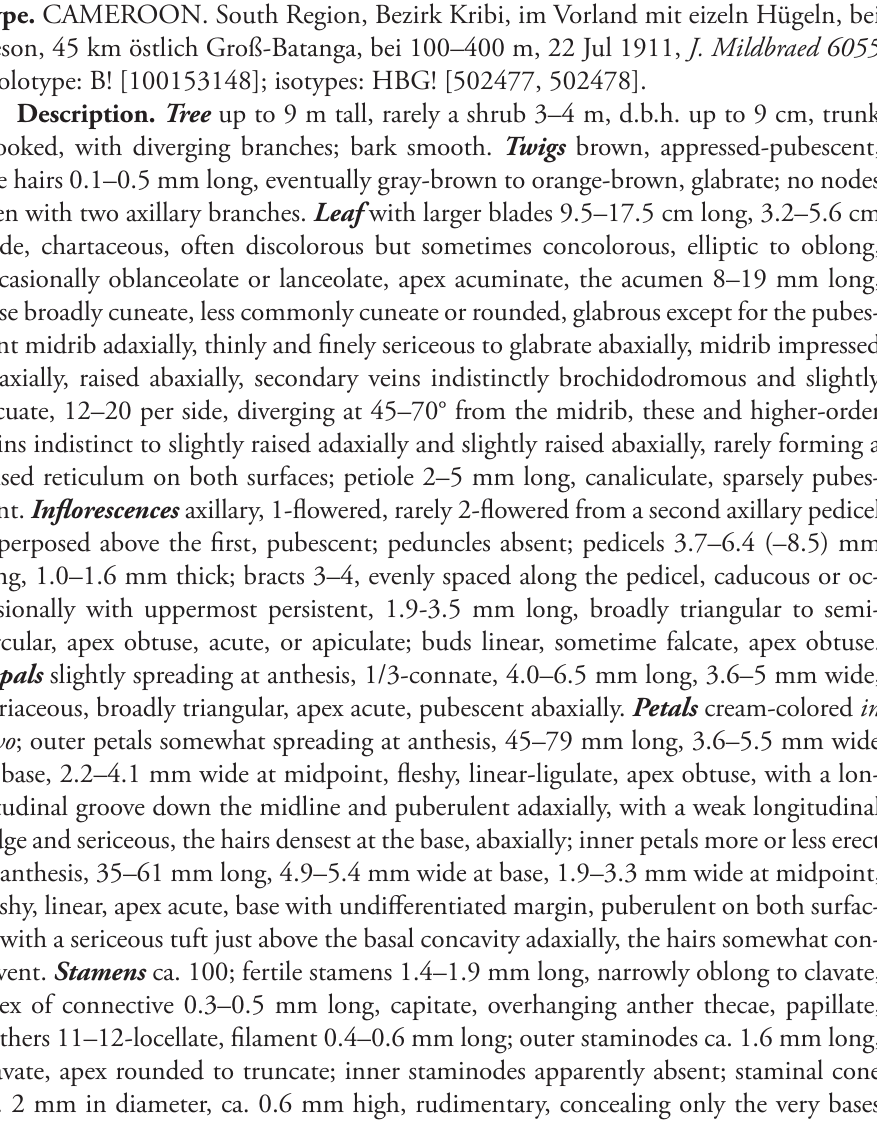
Xylopia lastoursvillii Pellegrin, Mém. Soc. Bot. France 1949: 71.